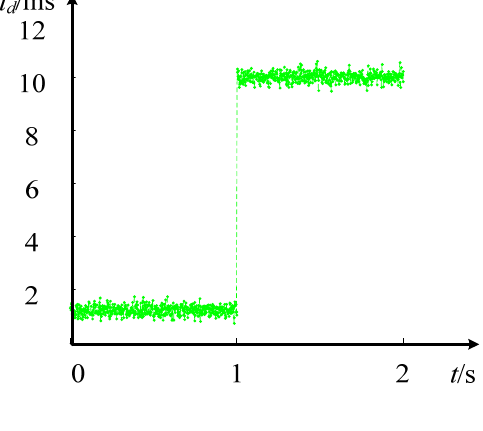
Figure 18. Consistent delay